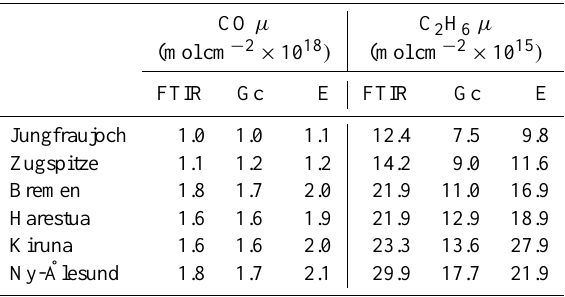
Table 6. Linear trends estimated from the partial columns (below 100hPa) of CO and C 2 H 6 from FTIR measurements. The trends are presented with their 2- σ confidence intervals and used the average value of 2001 as reference.